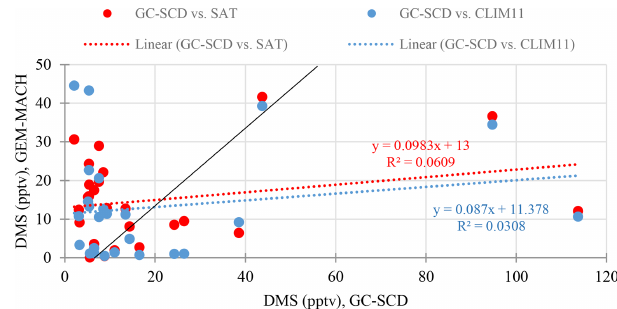
Figure 6. The GC-SCD observation results onboard the Polar 6 air- craft vs. model simulations (SAT and CLIM11) during July 2014. The linear regression method is used to obtain the correlation be- tween observation and model results. The solid black line is the one-to-one